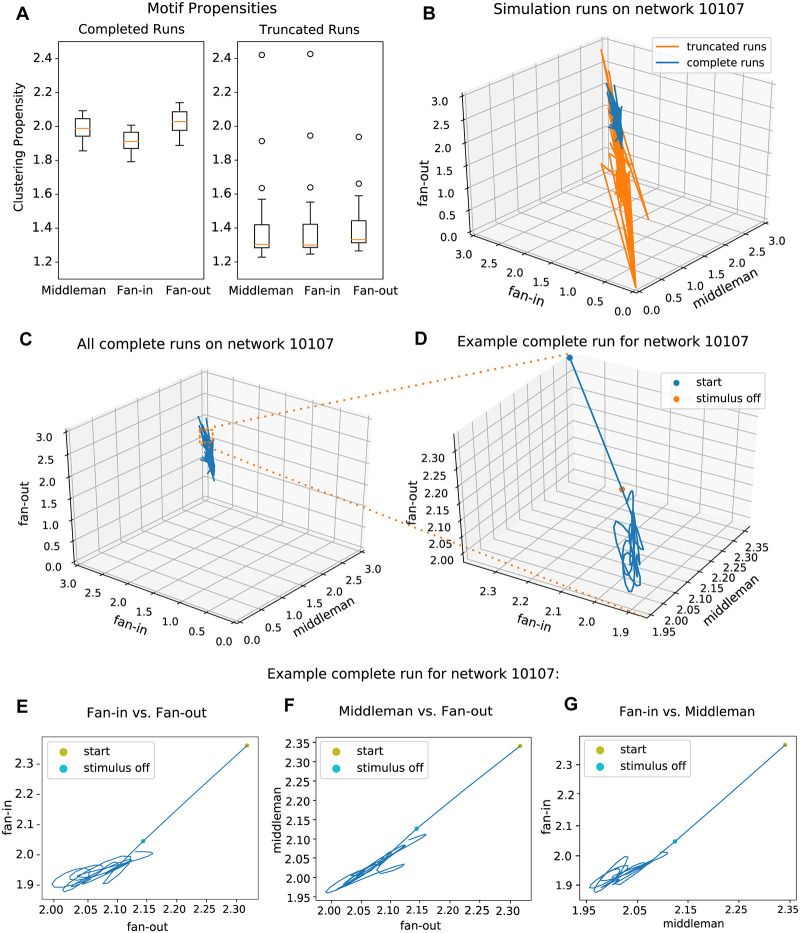
Standard network triplet motifs.A: Comparison of triangle motif clustering propensities of the three isomorphic motifs on sustained and truncated runs across all networks. B: Trajectories of all runs on a sample network in 3-dimensional isomorphic motif space. Truncated runs have a larger spread of trajectories along with variation in the ratios of inhibitory to excitatory spike rates. However, sustained runs are consistent in their spike rate ratios. C: Trajectories of all sustained runs alone, on axes of the identical scale as in panel B. D: Example trajectory of a single run on the same network, now enlarged (from inset in panel C). The network begins away from the area of its eventual cyclic trajectory, and the 30ms of Poisson input at the beginning of the run drives it towards this region. E: Example trajectory from panel D shown as fan-out propensity vs fan-in propensity. F: Example trajectory from panel D shown as fan-out propensity vs middleman propensity. G: Example trajectory from panel D shown as fan-in propensity vs middleman propensity.